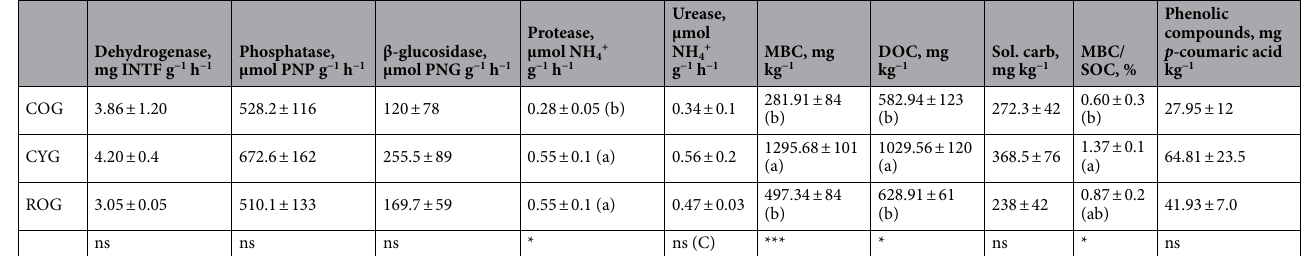
contrast, the MBC/SOC ratio was significantly lower (p = 0.0061) in reforested soil than pasture.